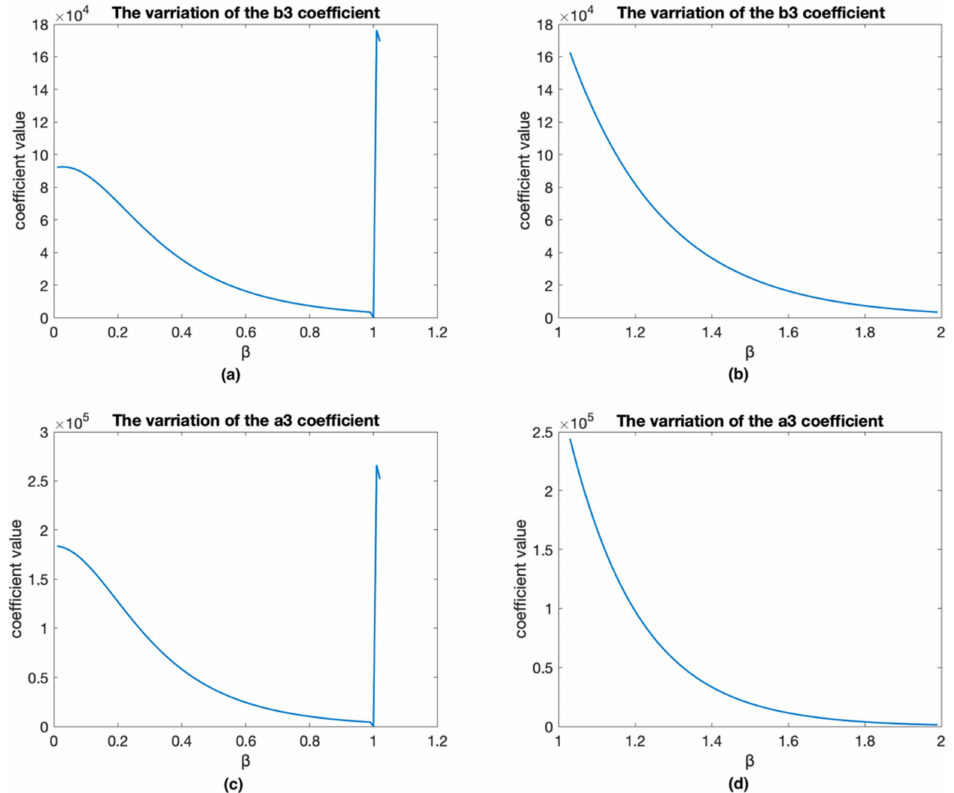
Figure 6. The evolution of the transfer function b 3 and a 3 coefficients: ( a ) The evolution of the transfer function b 3 coefficient in relation to β ( β (cid:101) ( 0;1.02 ]) ; ( b ) The evolution of the transfer function b 3 coefficient in relation to β ( β (cid:101) ( 1.02, 1.99 ]) ; ( c ) The evolution of the transfer function a 3 coefficient in relation to β ( β (cid:101) ( 0;1.02 ]) ; ( d ) The evolution of the transfer function a 3 coefficient in relation to β ( β (cid:101) ( 1.02, 1.99 ])